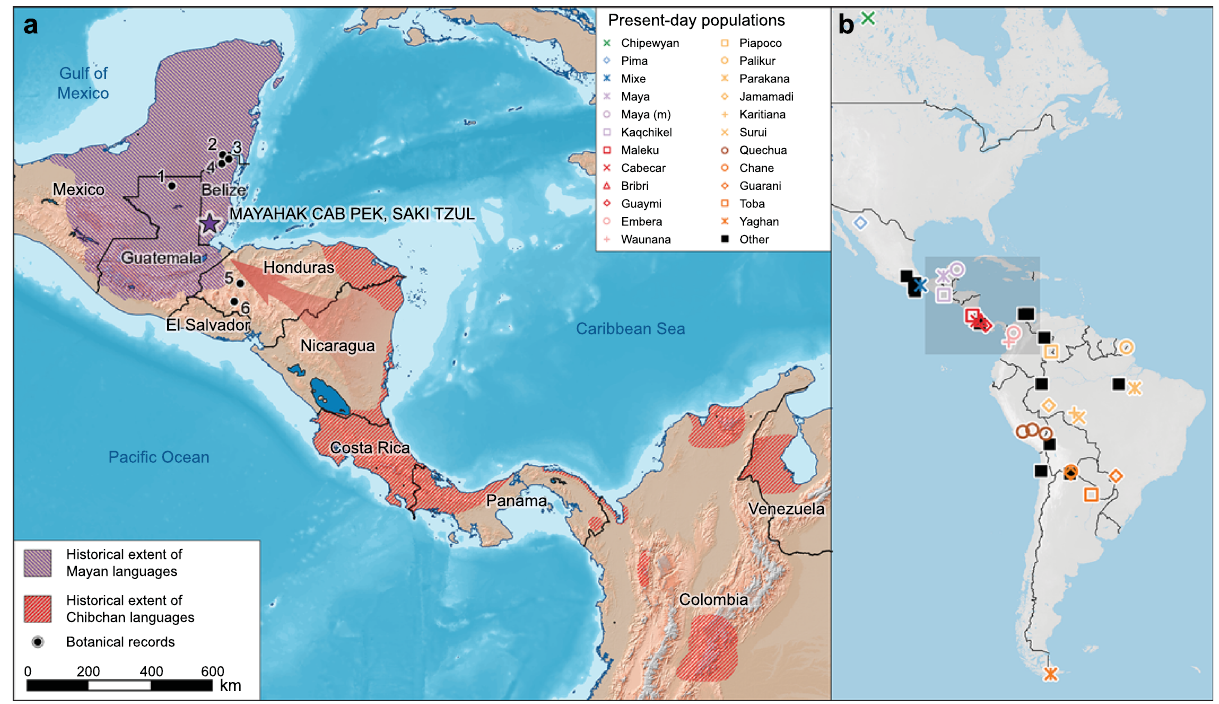
Fig. 1 Extent of Mayan and Chibchan languages, paleobotanical records showing early horticulture, and present-day populations with genome-wide data analyzed in this study. a Location of MHCP and ST is shown relative to the historical distributions of people speaking Mayan (purple) 46 and Chibchan (red) 45 languages. Paleo-botanical records from the southeastern Yucatan and adjacent areas with evidence of maize, manioc, and chili pepper between 6500 and 4000 cal. BP are shown in black as: 1) Lake Puerto Arturo 26 ; 2) Cob Swamp 24 ; 3) Rio Hondo Delta 25 ; 4) Caye Coco 23 ; 5) Lake Yojoa 27 ; and 6) El Gigante rock-shelter 28 . The arrow shows the proposed movement of Isthmo-Colombian horticultural populations into the southeastern Yucatan by at least 5600 cal. BP. b Distribution of present-day groups with genome-wide comparative data (also see Supplementary Fig.